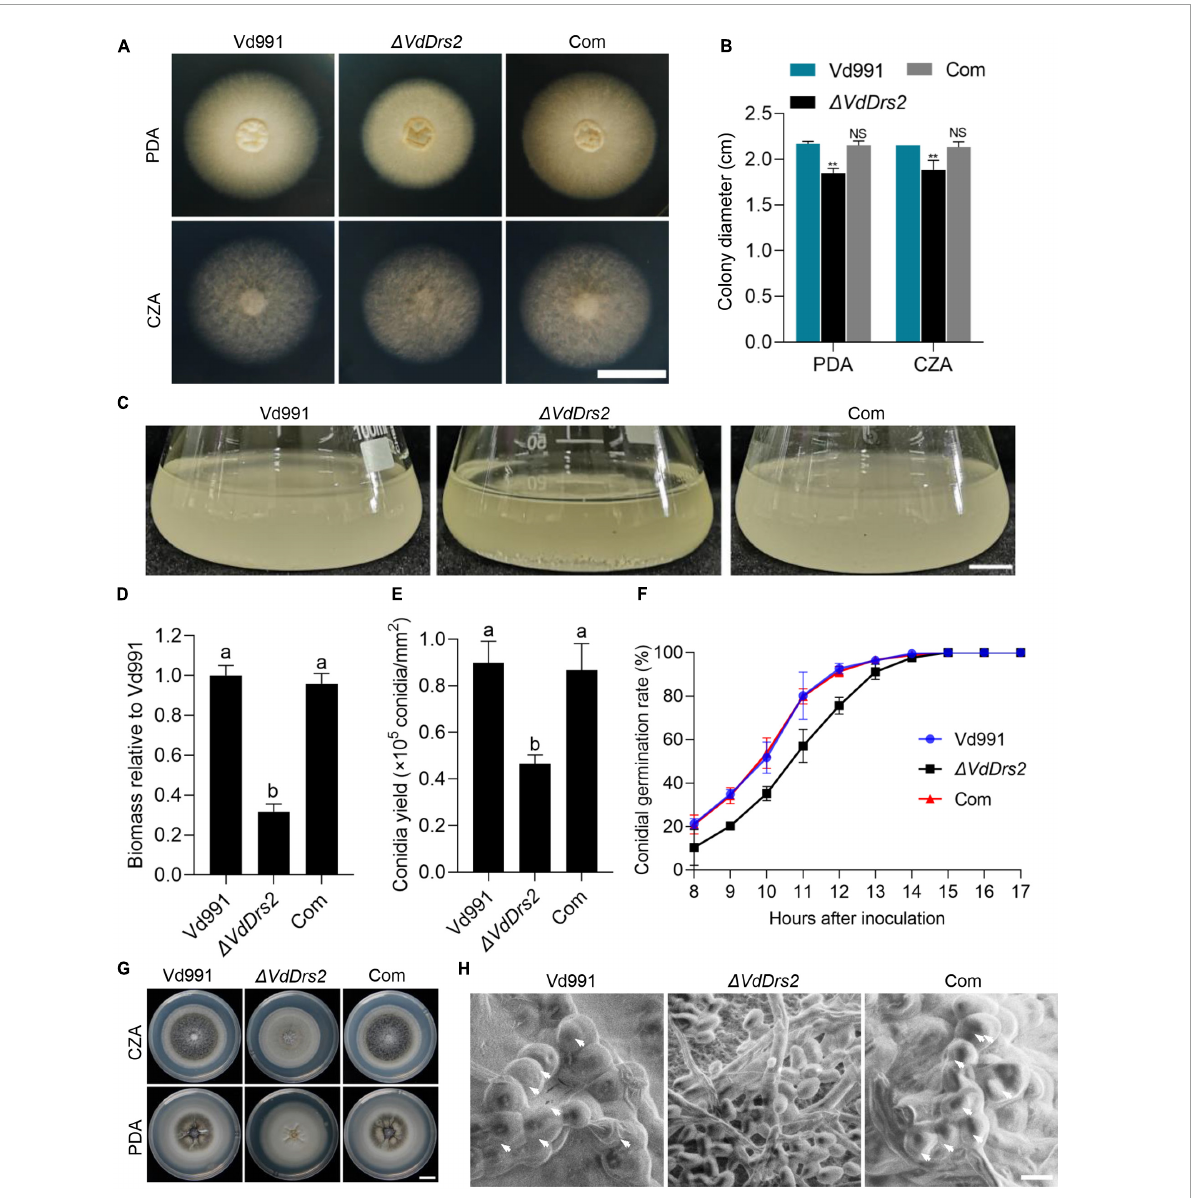
FIGURE5 Disruption of VdDrs2 decreases the colony growth, biomasses, sporulation, and microsclerotia formation and delays conidia germination. (A,B) Disruption of VdDrs2 decreased the growth of V. dahliae . Vd991, wild type strain; (cid:49) VdDrs2 , VdDrs2 knocked-out strain; Com, VdDrs2 -complemented strain. The strains were cultivated on PDA and CZA plates at 26 ◦ C for 7 days. Scale bar represents 1 cm. Two groups of data were compared using t tests in SPSS. ** P < 0.01, NS: not significant. (C,D) Disruption of VdDrs2 reduced biomass of V. dahliae . Scale bar represents 1 cm. Different letters (a, b) indicate a significant difference ( P < 0.05) based on one-way ANOVA with Tukey multiple comparisons test. (E) Knockout of VdDrs2 reduces the conidial yields of V. dahliae . Different letters (a, b) indicate a significant difference ( P < 0.05) based on one-way ANOVA with Tukey multiple comparisons test. (F) Knockout of VdDrs2 delayed conidial germination of V. dahliae . Conidia were cultivated onto PDA plates, and the germination rate was counted hourly from 8th hours until all the conidia have germinated. Each strain assay was performed thrice. The error bars indicate standard deviations from three repeats of the experiment. (G) Knockout of VdDrs2 impaired melanin production. Vd991, (cid:49) VdDrs2 , and Com strains were cultivated on PDA and CZA plates at 26 ◦ C for 14 days. Scale bar represents 1 cm. (H) Scanning electron microscope of microsclerotia formation. White arrows indicate microsclerotia. Scale bar represents 5 µ